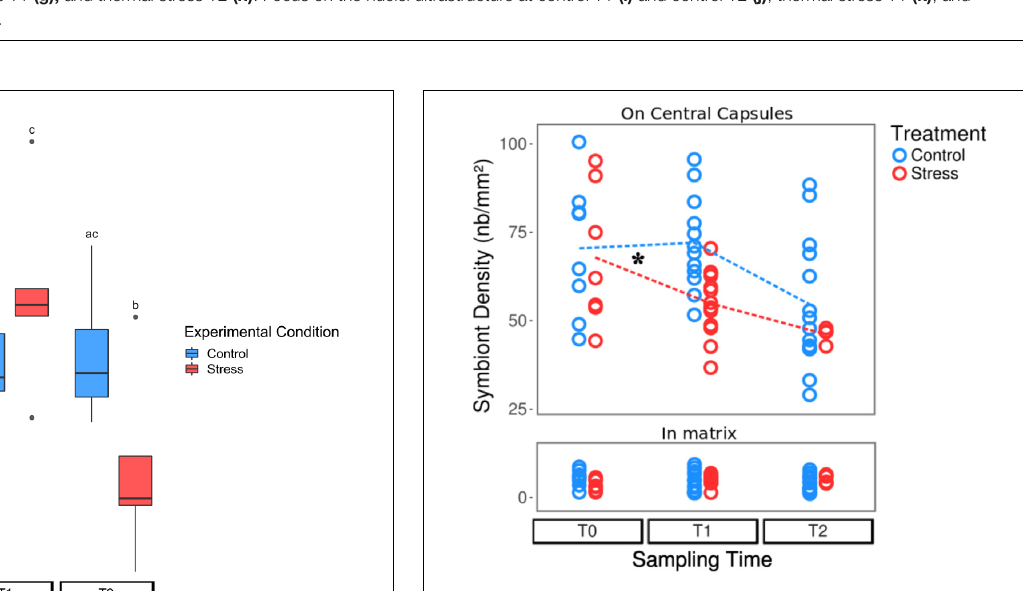
cells to maintain a healthy population in symbiosis, whereas